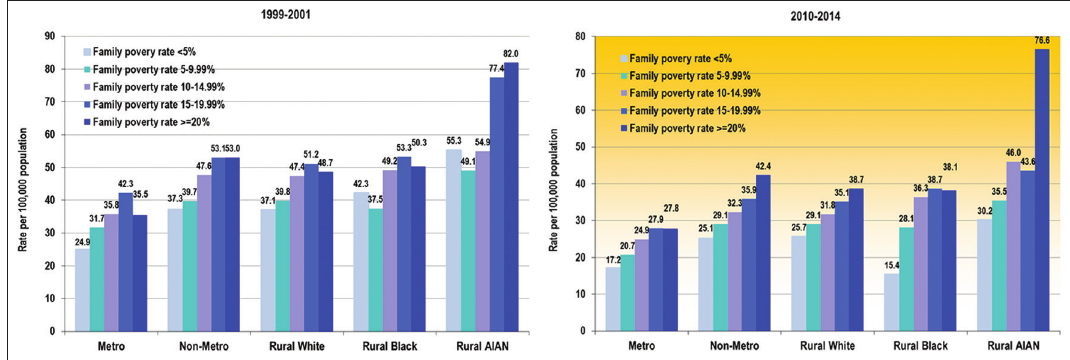
Figure 11. Child and Adolescent (1-19) Mortality Rates by County-Level Family Poverty Rate, United States, 1999- 2001 and 2010-2014 Source: Data derived from the National Vital Statistics